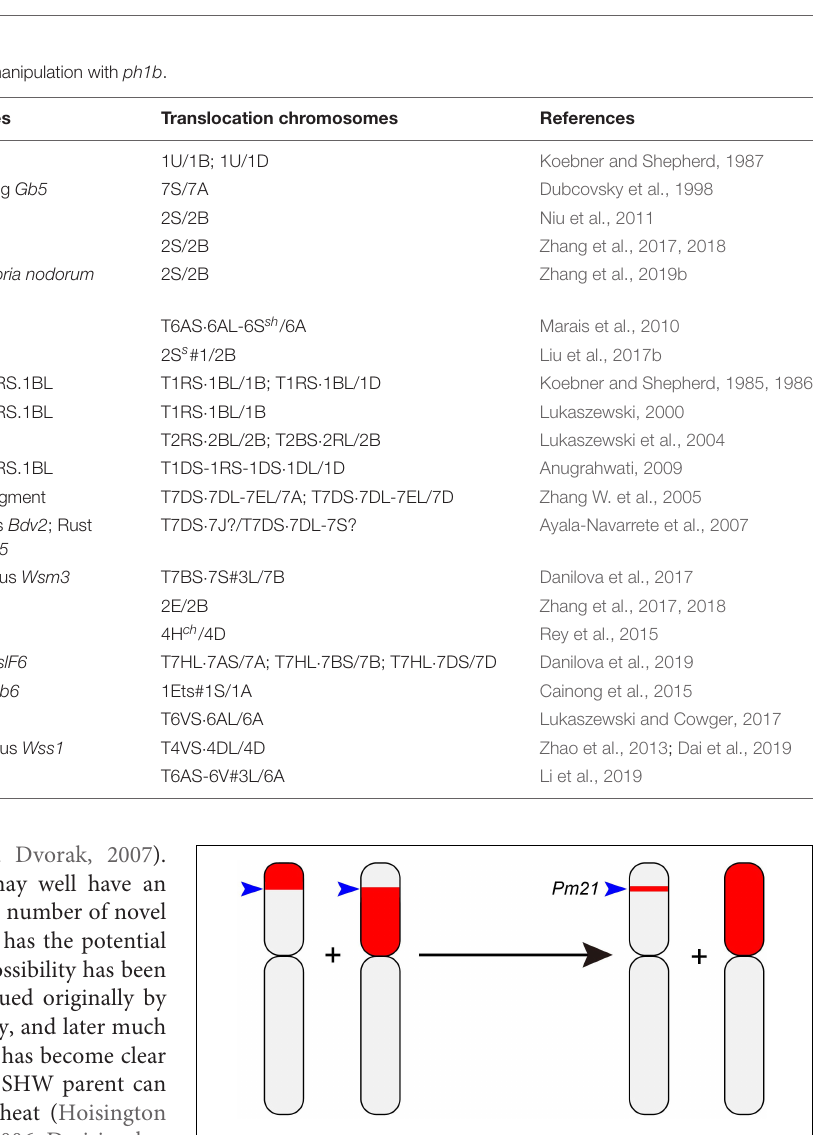
FIGURE 2 | The introgression of a small fragment of Ha. villosa chromosome 6V into a distal site of wheat chromosome arm 6AS. Two independent introgression lines were inter-crossed: one carries the terminal portion of chromosome arm 6VS and the other a proximal segment, while both carry Pm21 , which lies in the short common interstitial segment. As a result of a homologous recombination event in the F 1 hybrid, segregants are generated which carry only the short interstitial segment [Figure redrawn from Lukaszewski and Cowger